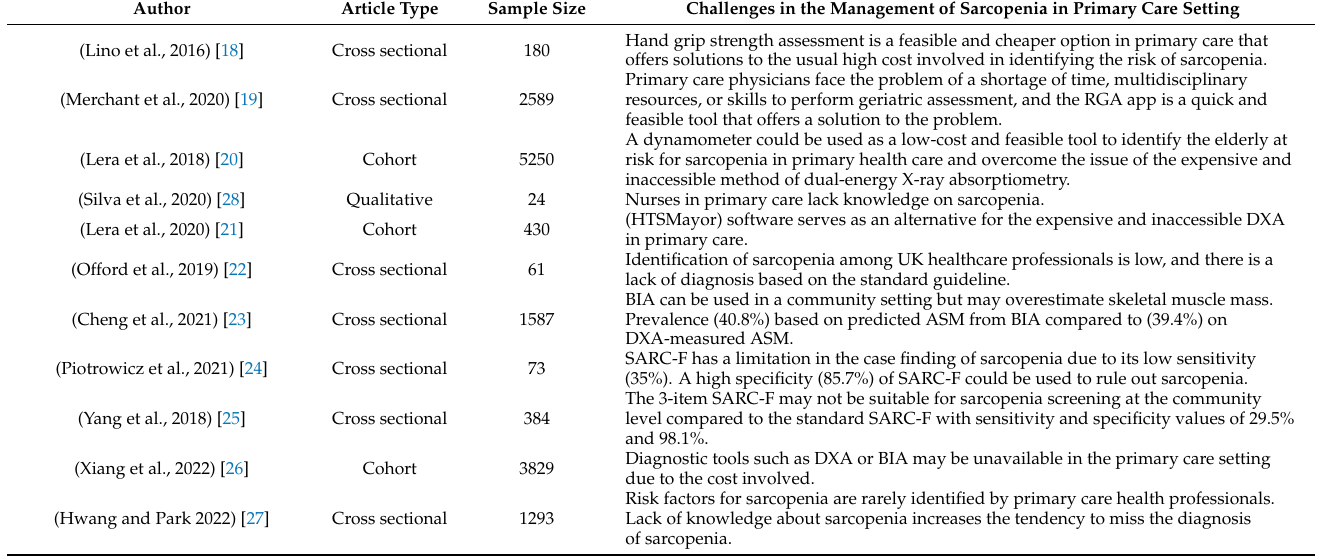
Table 3. Summary of